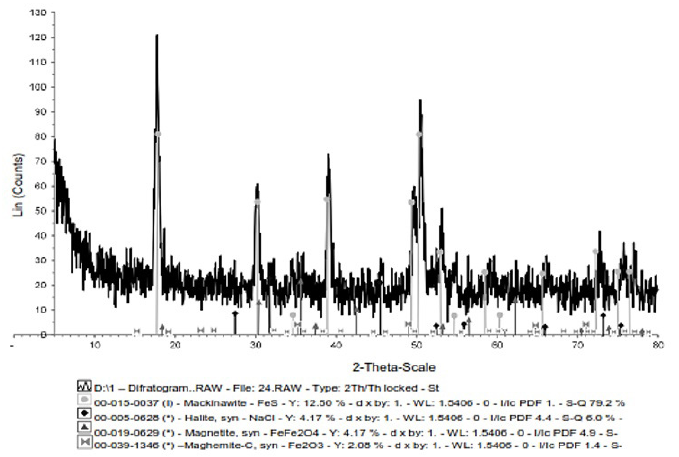
Figure 12. XRD spectrum of the corrosion product film of the welded joint that was tested in solution 1 with